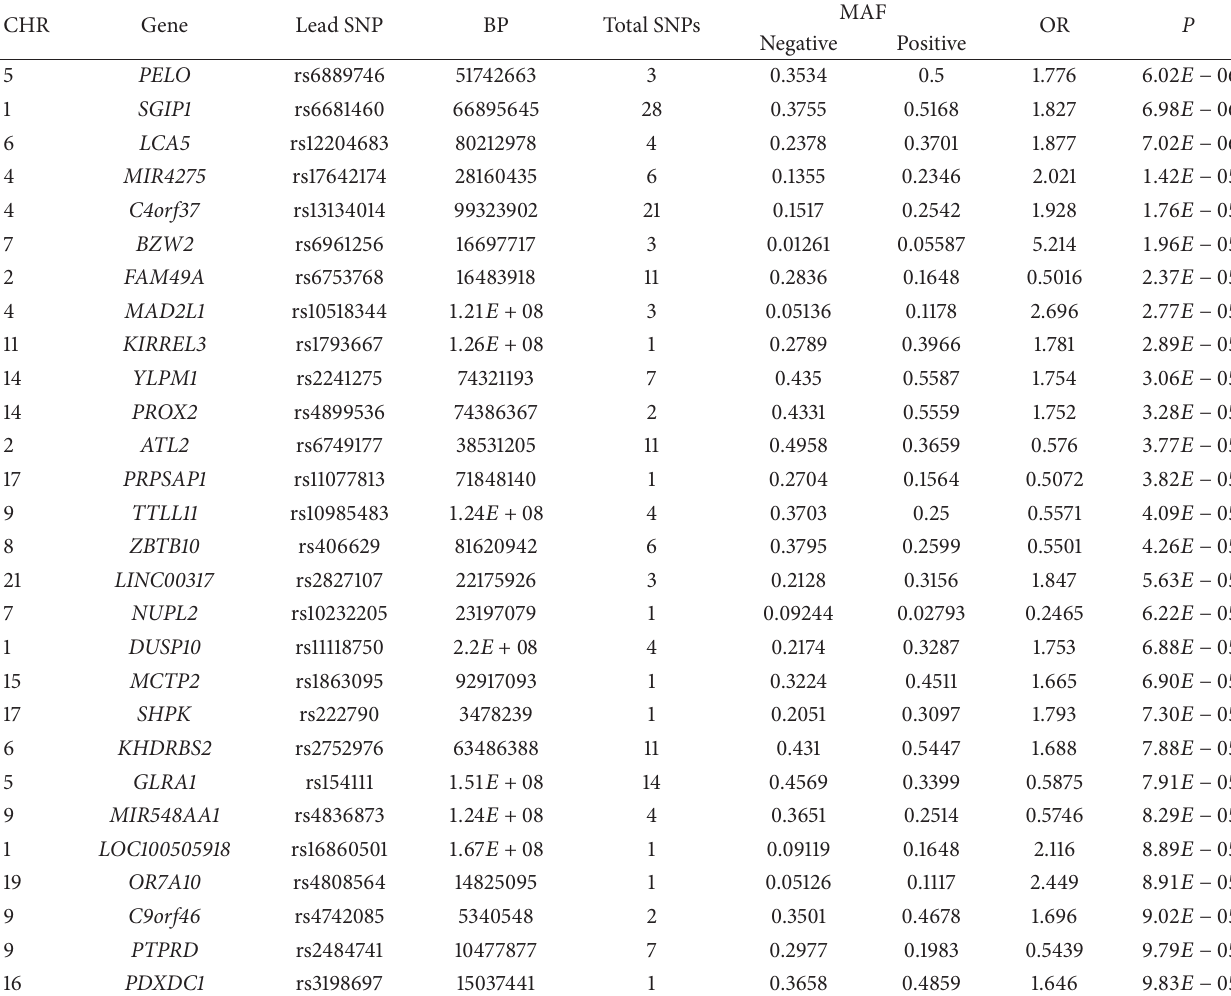
Table 2: Genetic loci associated with the occurrence of ACL with 𝑃 < 1𝐸 − 04 ∗